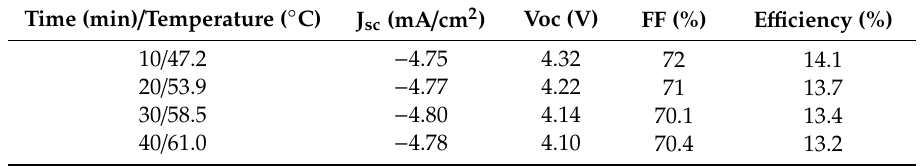
Table 2. Time dependence of the solar cell performance under air mass (AM) 1.5 G